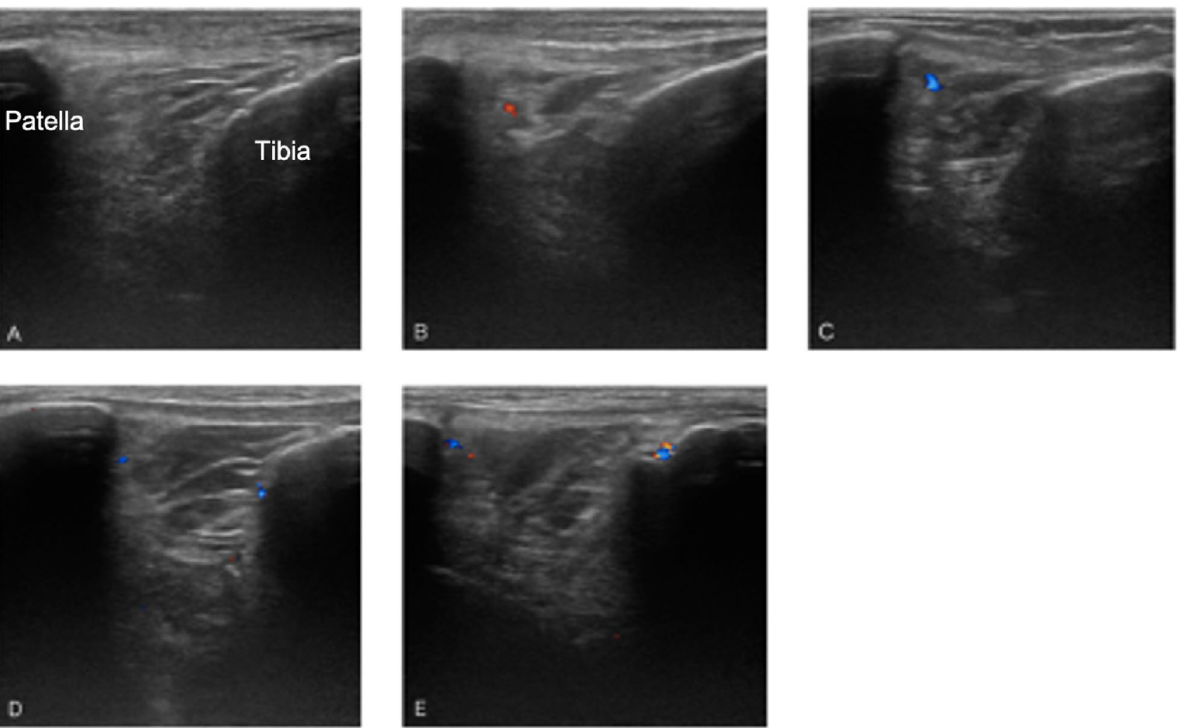
Figure 2. Representative Color Doppler signals. ( A ) shows no blood signals were observed in the IPFP (grade 0). ( B ) and ( C ) Single vessel signal was observed in the IPFP (grade 1). ( D ) and ( E ) More than two vessel signals in less than half of the area of the IPFP (grade 2). Prior to acquisition of data, two examiners examined five randomly selected subjects to assess inter-reproducibility of ultrasound examination. Perfect agreement was